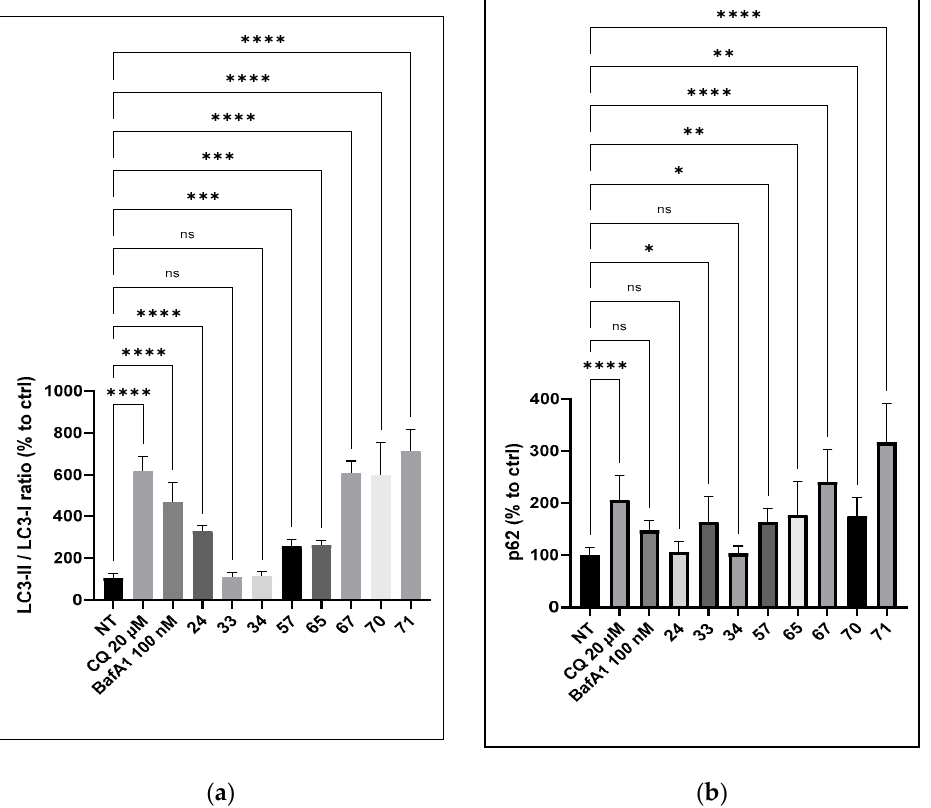
Figure 3. Effect of compounds 24 , 33 , 34 , 57 , 65 , 67 , 70 , and 71 on the autophagic flux in SY5Y-APP wt cells. SY5Y-APP wt cells were treated for 24 h with compounds 24 , 33 , 34 , 57 , 65 , 67 , 70, and 71 (3 µM), CQ (20 µM), and bafilomycin A1 (BafA1) at 100 nM as the control. Cell lysates were immunolabeled with the following antibodies: p62 ( a ), LC3 ( b ), and β -actin. Statistical significance was set at * p < 0.05, ** p < 0.001, *** p < 0.001, **** p < 0.0001, and ns as not significant.